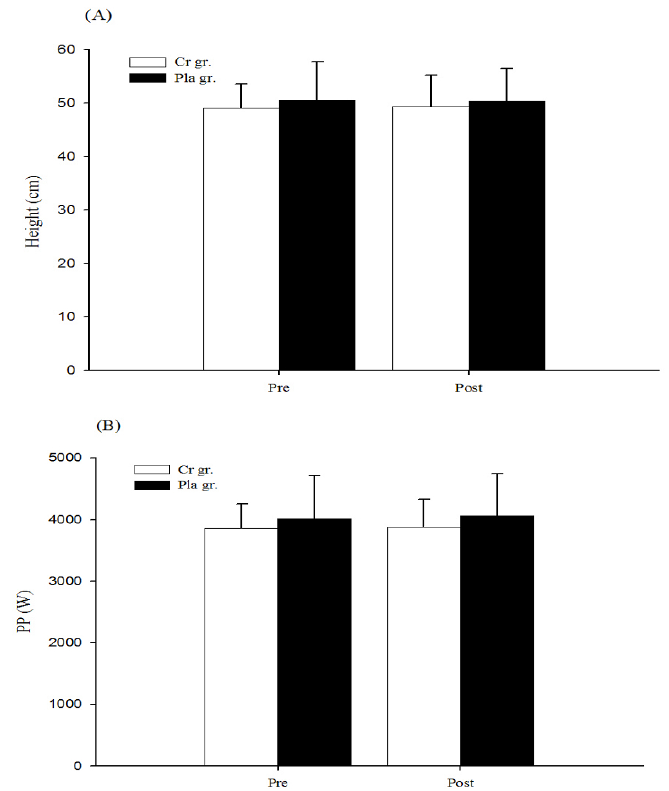
Figure 2. ( A ) Height and ( B ) peak power (PP) of counter movement jump of optimal individual postactivation potentiation (PAP) time following creatine or placebo supplementation. Data are the mean ± SD.